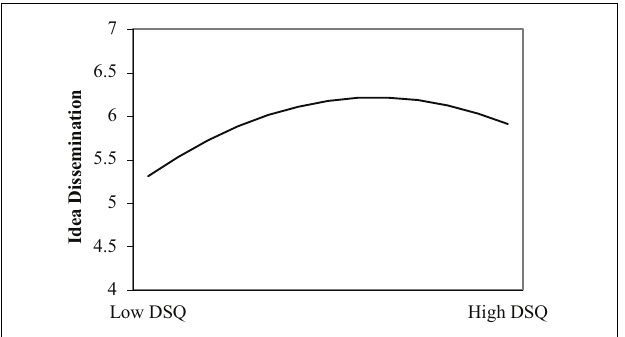
FIGURE 2 | The Inverted U-shaped relationship between dissatisfaction with the status quo (DSQ) and idea